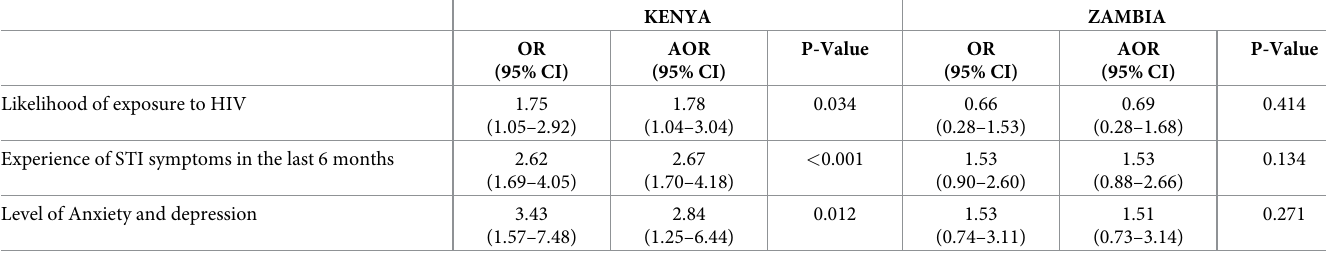
KENYA ZAMBIA OR AOR P-Value OR AOR P-Value (95% CI) (95% CI) (95% CI) (95% CI)